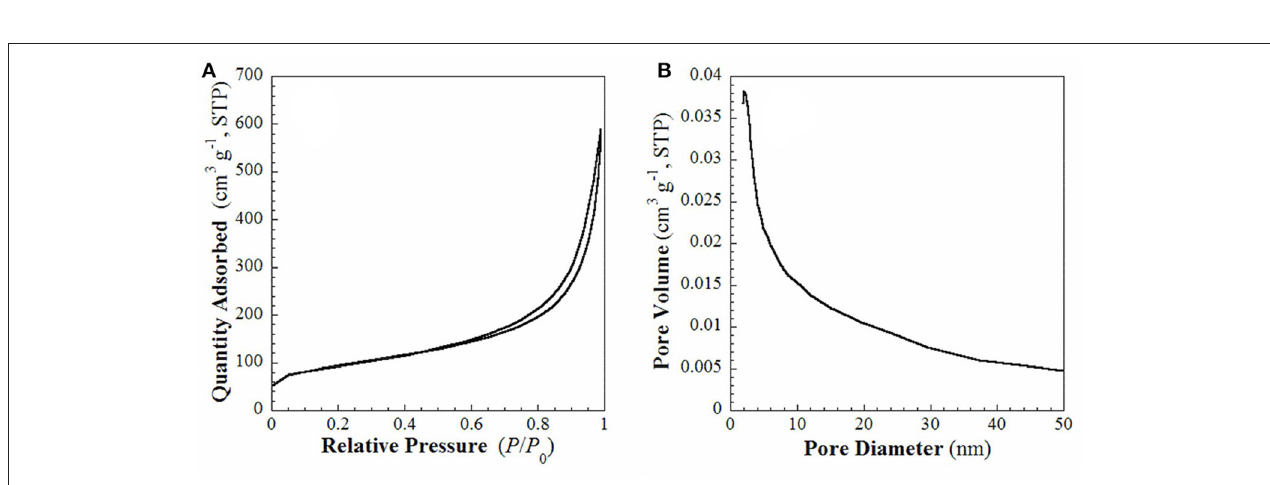
FIGURE 4 | (A) N 2 adsorption-desorption isotherms and (B) BJH pore size distribution plot calculated from the adsorption branch of sample S2 .